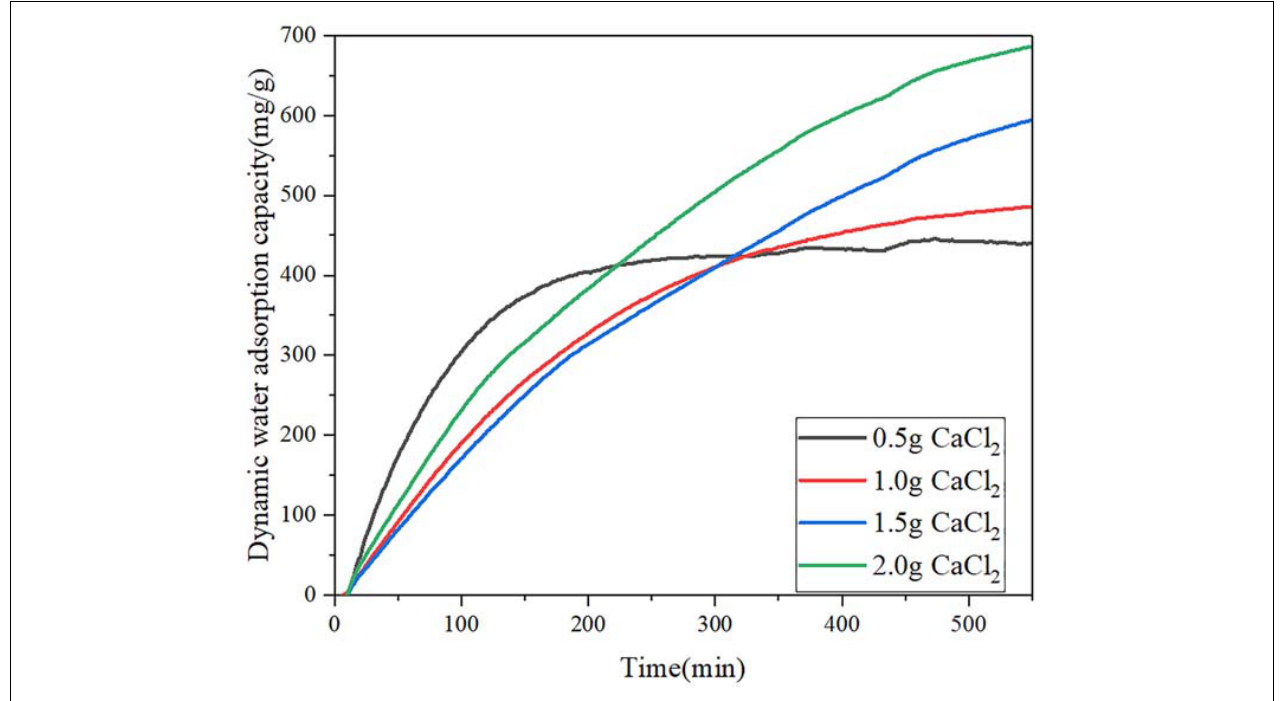
FIGURE 7 | Dynamic water adsorption curve of calcium chloride mil-101 (Cr) composite.